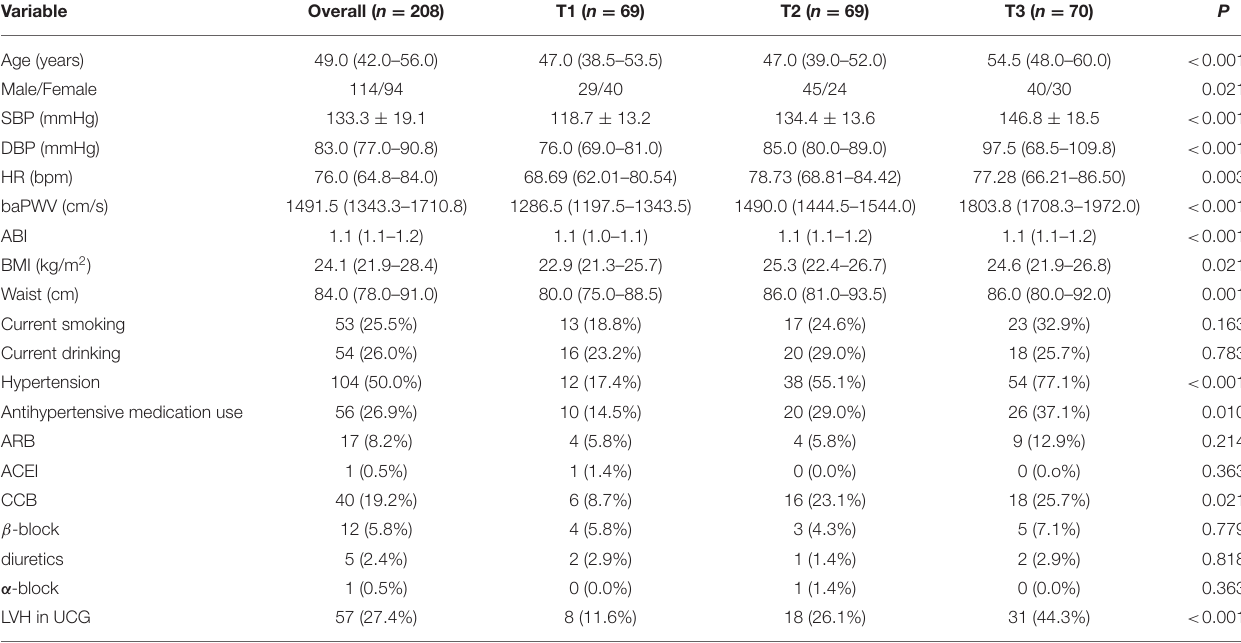
TABLE 1 | Baseline clinical characteristic in the study population and in tertile groups.